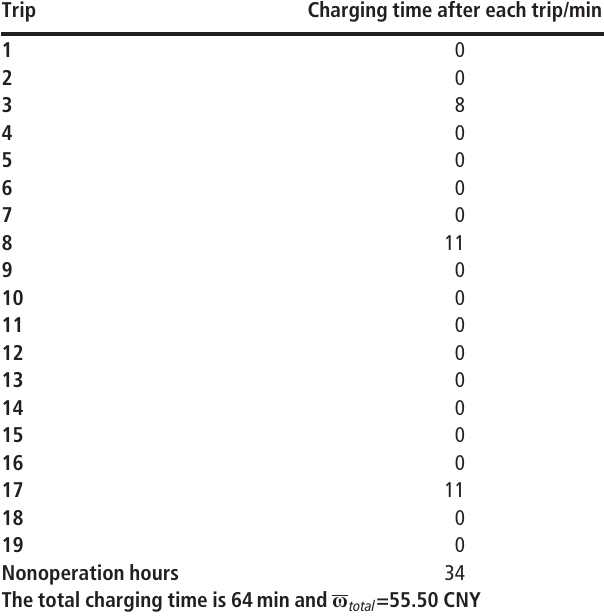
Table 7 Optimal charging plan under model 2